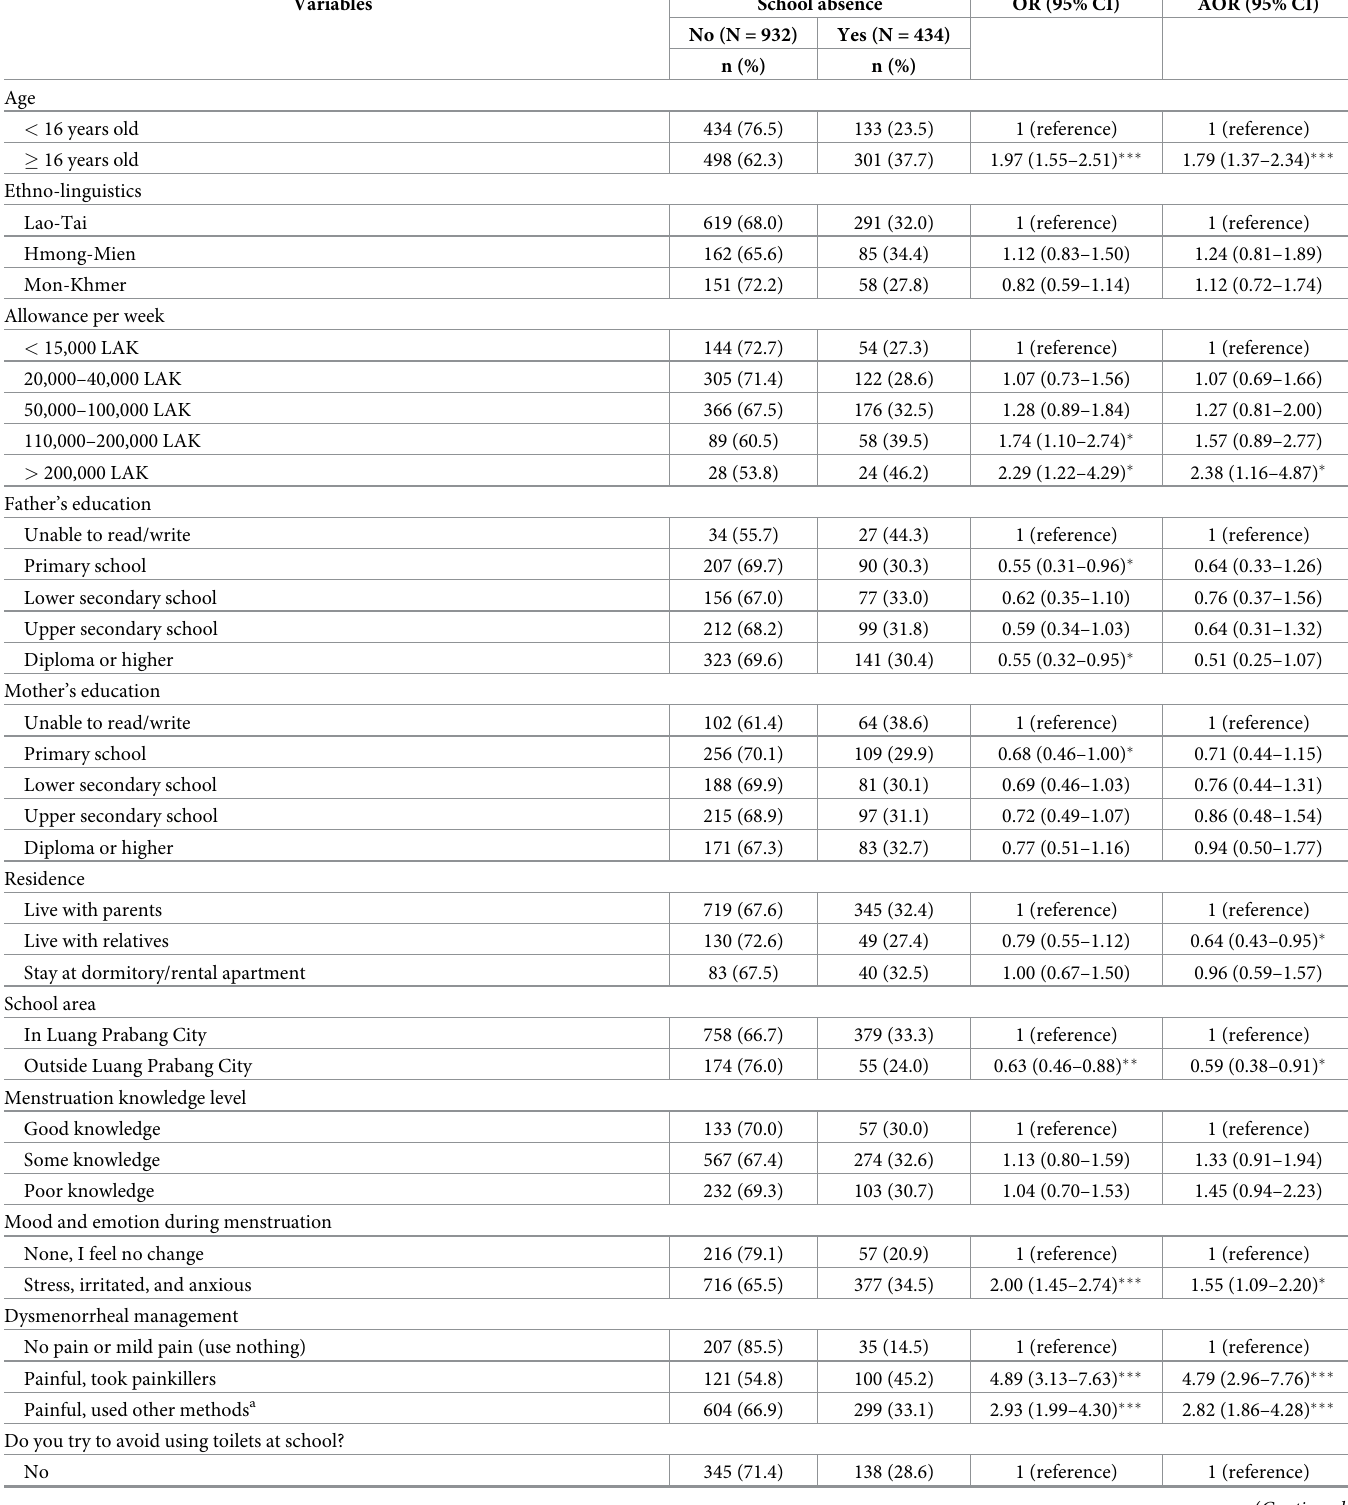
Table 6. Binary and multivariate analysis on school absence due to